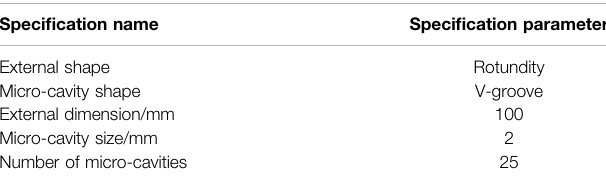
TABLE 3 | Dimensions of the area